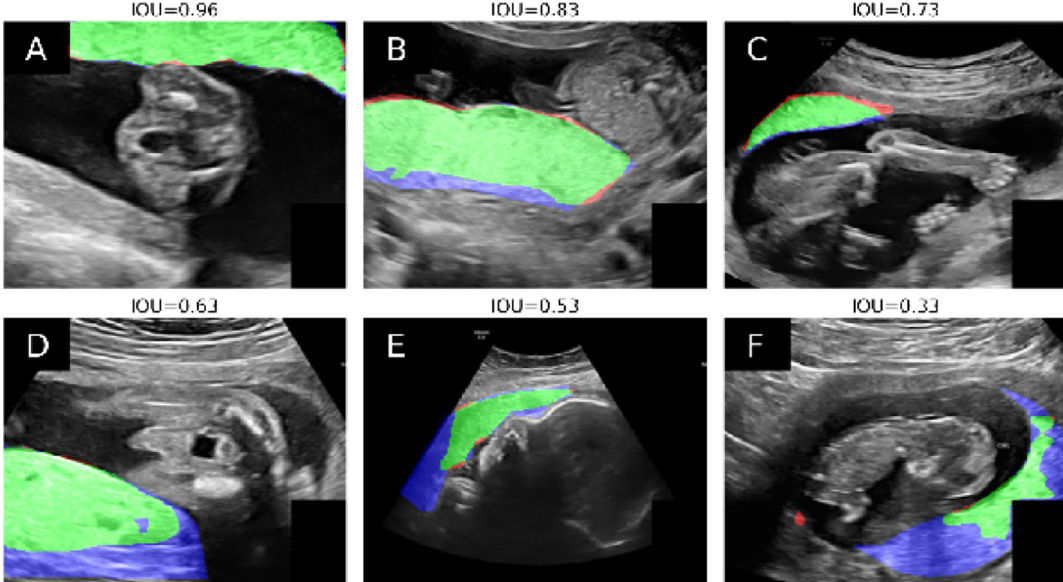
Figure 3. Six annotation examples, including model prediction (red), ground truth (blue) and their overlap (green).